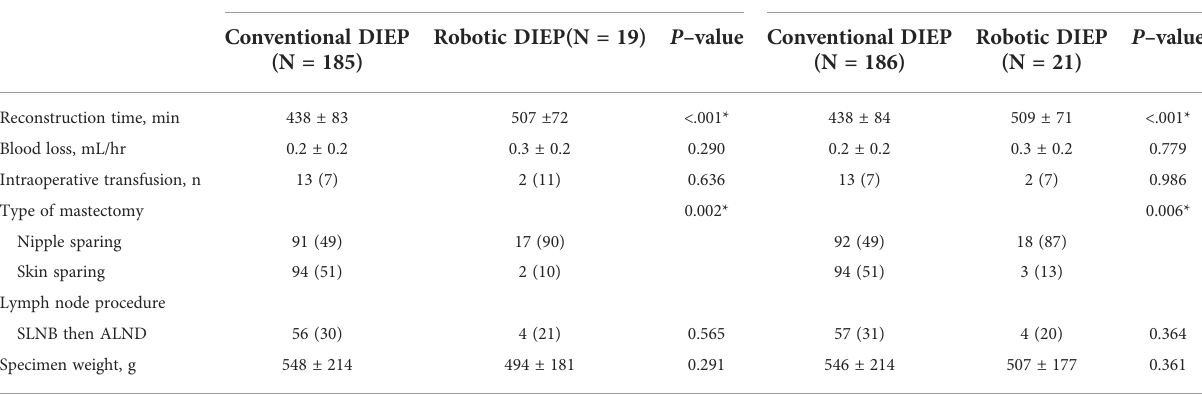
TABLE 2 Operative variables